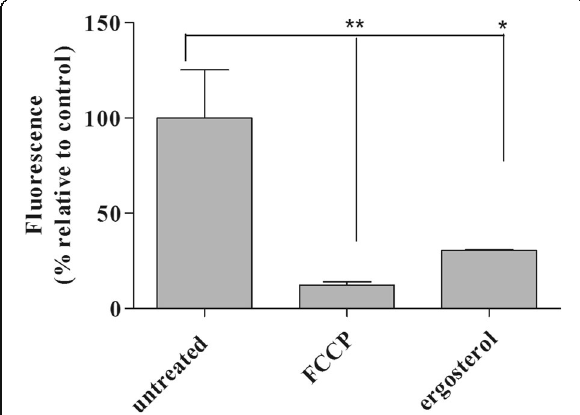
Fig. 3 Effect of ergosterol in the mitochondrial function of trypomastigotes. Fluorescence of Mitotracker Red CM-H2XROS dye (500 nM) was spectrofluorimetrically measured after 60 min of incubation. Maximal and minimal fluorescence was achieved by non- or FCCP (10 μ M) treatments, respectively. Fluorescence was quantified by calculating the mean percentage of untreated parasites (100%). * p < 0.001. A representative assay is shown